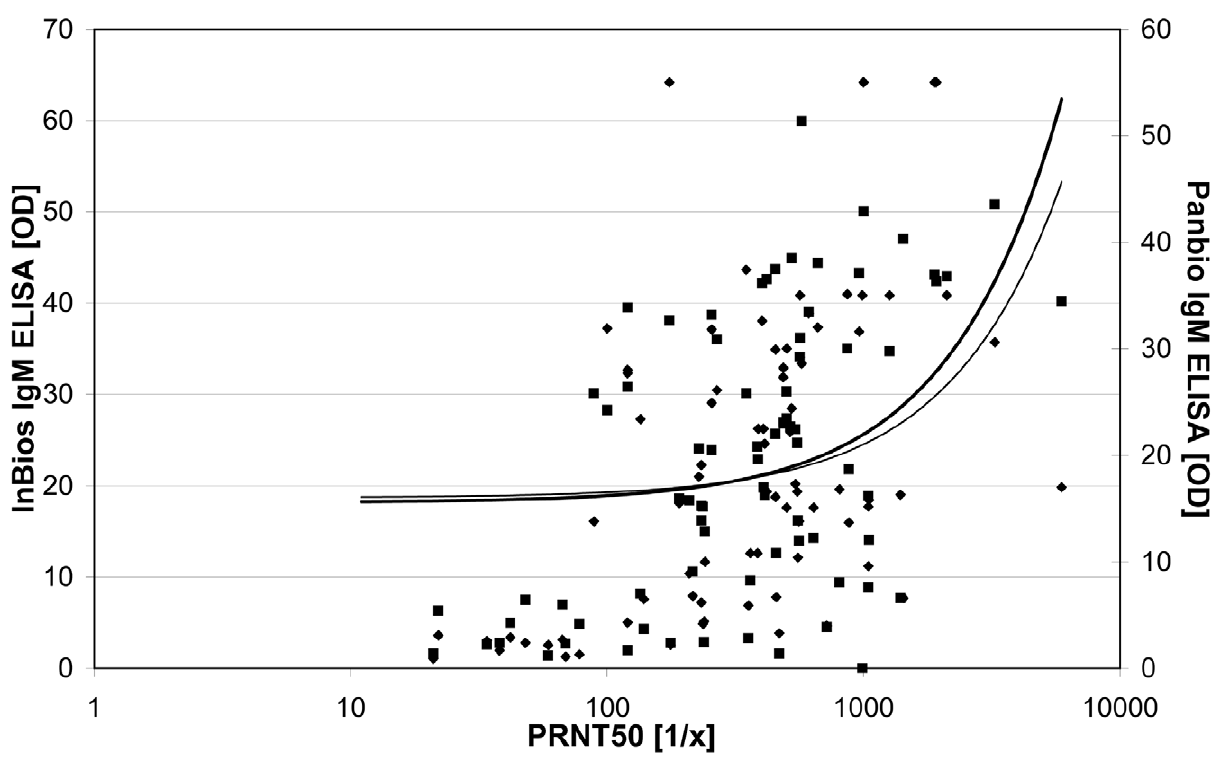
Figure 2. Scatter blot comparing the results of the PRNT50 with the results of both IgM ELISAs. Test values: Panbio IgM ELISA ( X ), InBios IgM ELISA ( & ). Trend line: Panbio IgM ELISA (thin), InBios IgM ELISA (thick).